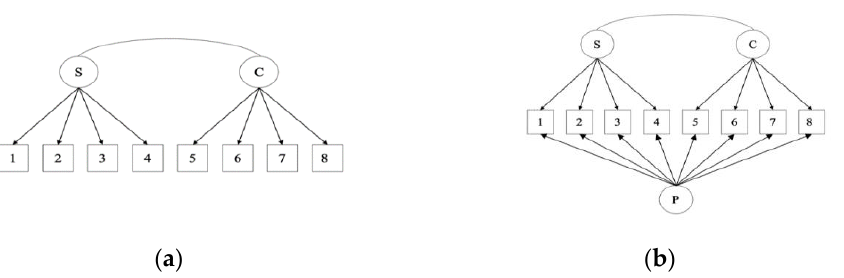
Figure 1. Tested factor structures of the FMPS-Brief; ( a ) Two-factor FMPS-Brief; ( b ) Bifactor FMPS- Brief; note: S = perfectionistic strivings, C = evaluative concerns, P = general perfectionism.